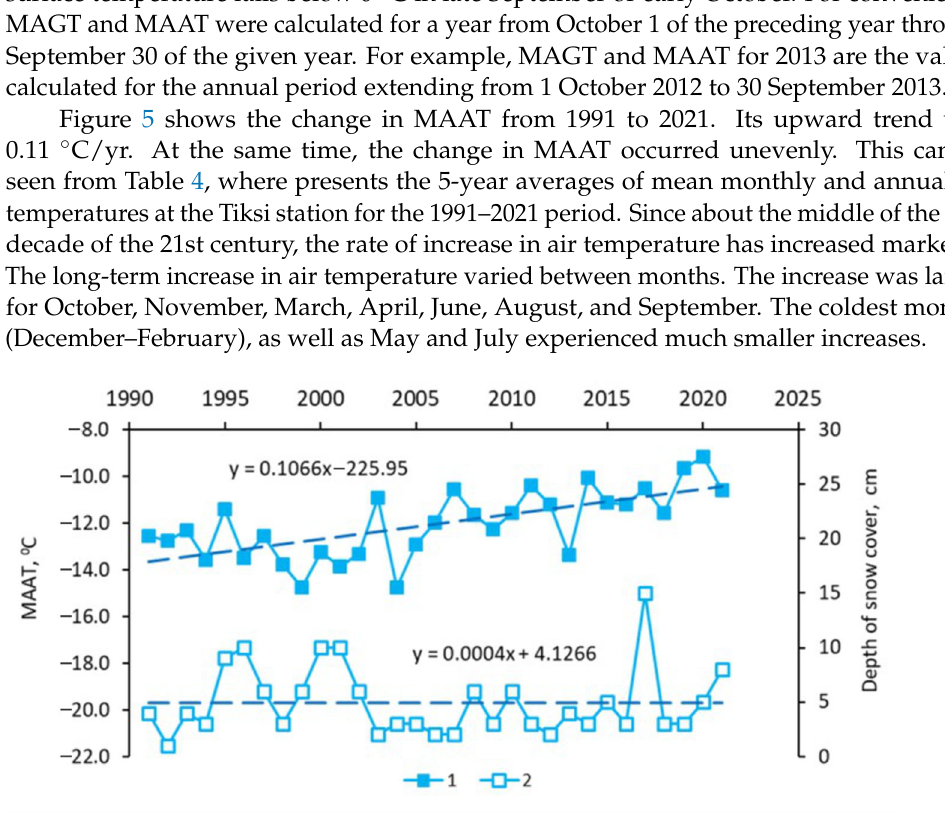
Figure 5. Mean annual air temperature (1) and maximum snow depth (2) in 1991–2021 for the Tiksi station. Table 4. Five-year averages of the mean monthly and annual air temperatures in 1991–2021 for the Tiksi meteorological station.